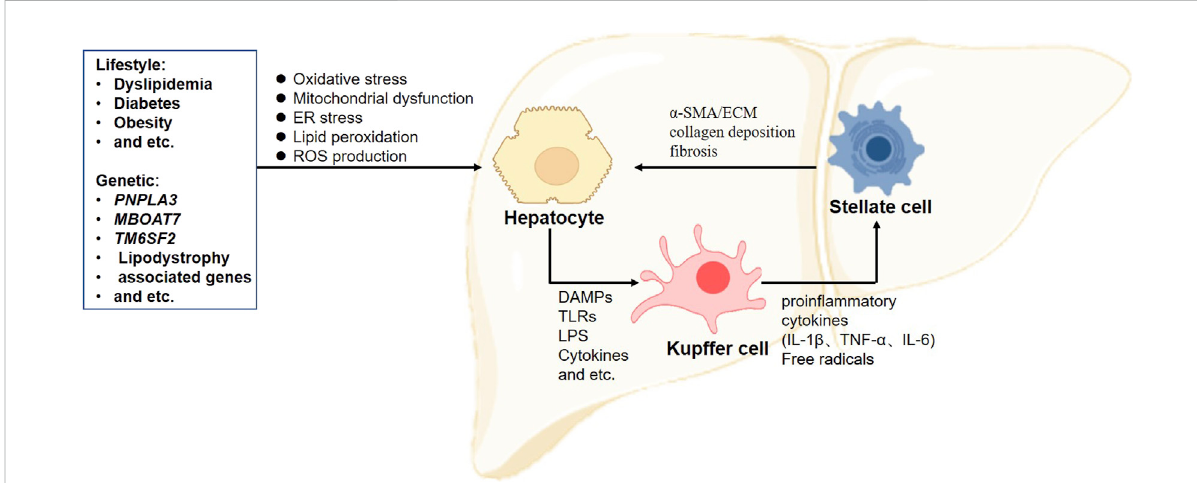
FIGURE 1 Crosstalkbetweenhepaticcellsintheprogressionofnon-alcoholicfattyliverdisease.Excessiveaccumulationsoftriglyceride,cholesterol,and lipid deposition are considered the fi rst steps to induce hepatocellular lipotoxicity, followed by oxidative stress, peroxidation, mitochondrial dysfunction,andreactiveoxygenspecies(ROS)production.ThesefactorspromotehepatocytedeathandthereleaseofDAMPsandTLRs,resultingin Kupffer cell activation. Activated Kupffer cells produce a series of proin fl ammatory cytokines to recruit blood monocytes to strengthen in fl ammation. When chronic in fl ammation is sustained, hepatic stellate cells are activated and undergo a phenotype switch from adipocyte-like quiescent cells to myogenic cells with increased expression levels of α -SMA and ECM proteins. Increased ECM synthesis and reduced ECM degradation lead to excessive collagen deposition and fi brosis progression in the liver. α -SMA, alpha-smooth muscle cell actin; DAMPs, damage- associated molecular patterns; ECM, extracellular matrix; ER, endoplasmic reticulum; IL, interleukin; ROS, reactive oxygen species; TNF- α , tumor necrosis factor alpha; TLRs, Toll-like